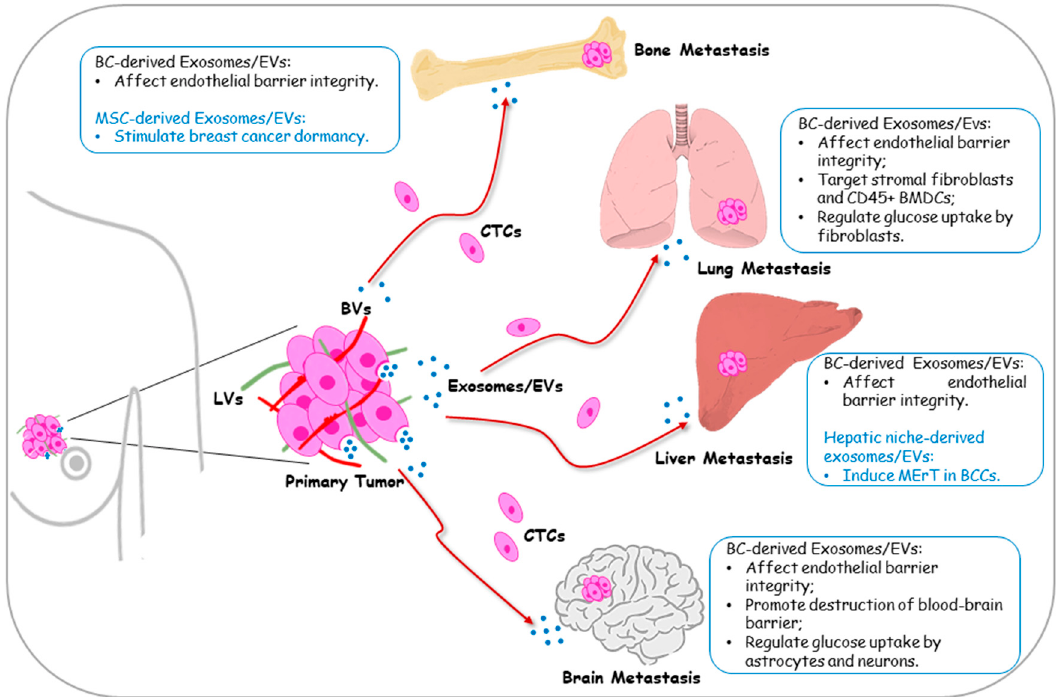
Figure 2. Schematic representation of the effects of exosome/extracellular vesicles (EVs) released by tumor cells and stromal cells in the establishment of metastatic outgrowth in breast cancer. Primary breast cancer ‐ derived exosomes drive organotropic metastasis of circulating tumor cells (CTCs) enabling their survival into blood (BVs) or lymphatic vessels (LVs) and establishing the permissive premetastatic niche at the distant sites: bone, lung, liver, and brain. The main mechanisms involved are summarized in the boxes near each metastatic site.